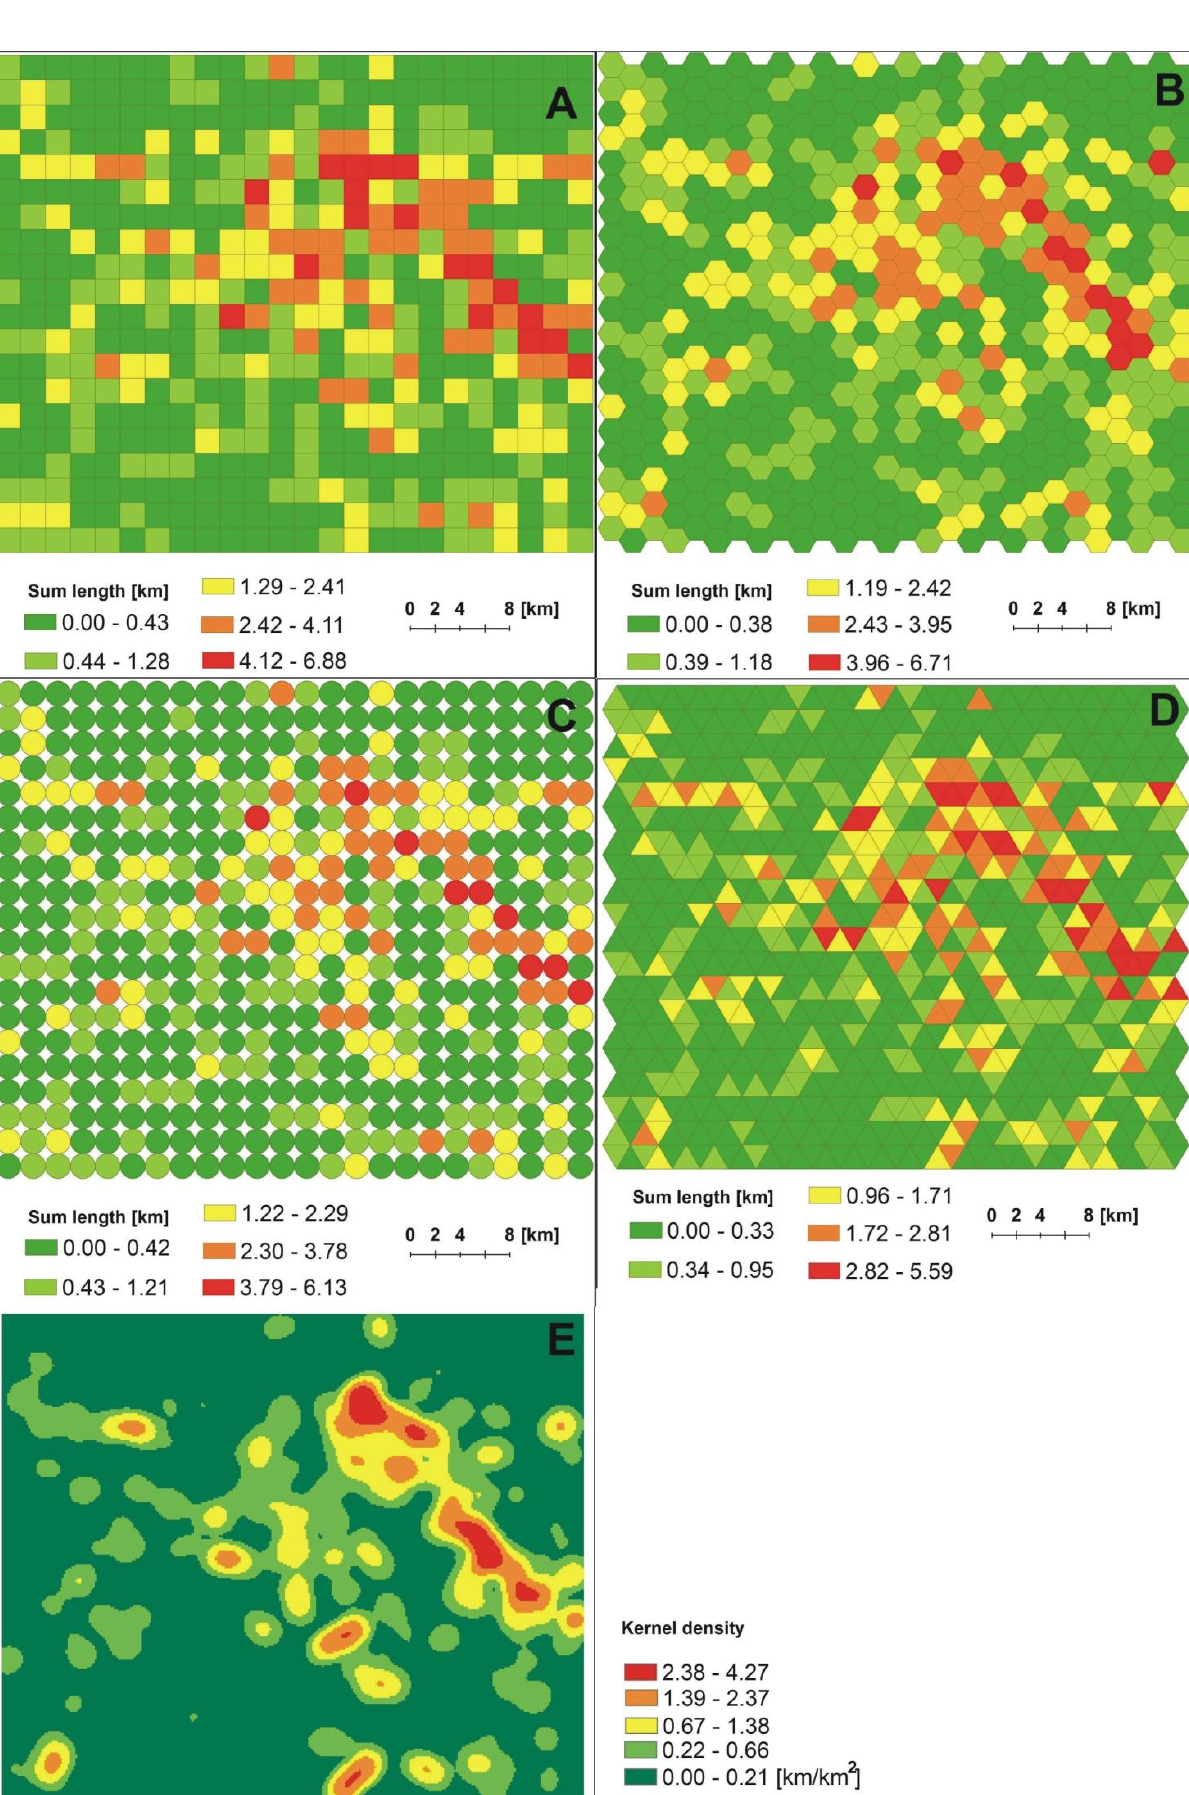
Fig. 8. Cartograms of line forms density in basic fields (2 km) A - squares, B - hexagons, C - circles, D - triangles and E - kernel